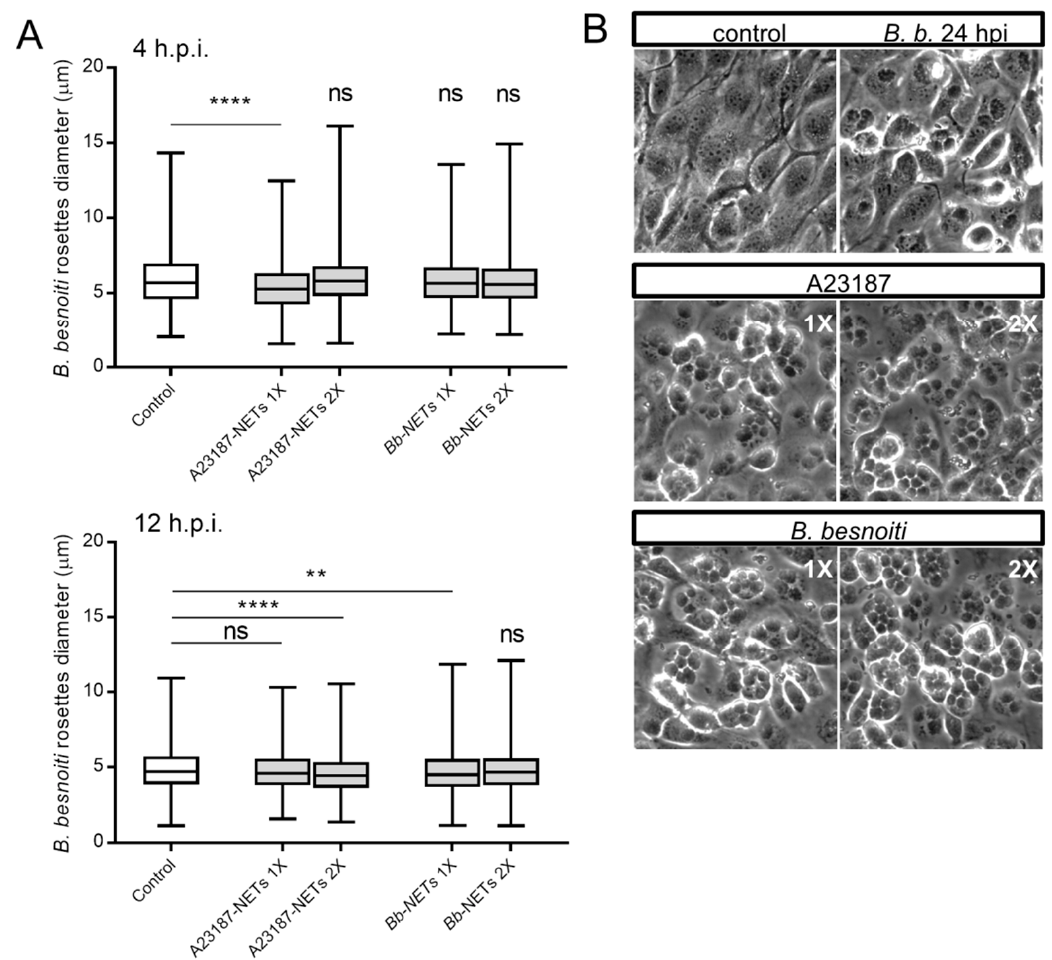
Figure 6. Bb -NETs and A231887-NETs induced a decrease in rosette diameter in B. besnoiti -infected BUVEC. Bb -NETs or A231887-NETs were added at two different concentrations (1X and 2X) to infected BUVEC cells (three different isolates, N = 3) at 4 ( A , upper panel) and 12 ( A , lower panel) h.p.i. At 24 h.p.i. experimental conditions were documented within five random pictures using a phase contrast microscope and the diameter of B. besnoiti rosettes was determined ( n = 1115). Box and whiskers plot, line at median, bars indicating maximum and minimum values. Statistical significance was determined by Kruskal-Wallis test followed by a Dunn´s post-test comparing experimental versus control condition at 4 and 12 h.p.i. ( A ). Representative images infected BUVEC cells to which Bb and A23187 NETs were added at 12 h.p.i. are shown ( B ). ns = non significant, ** p < 0.01, **** p < 0.0001.